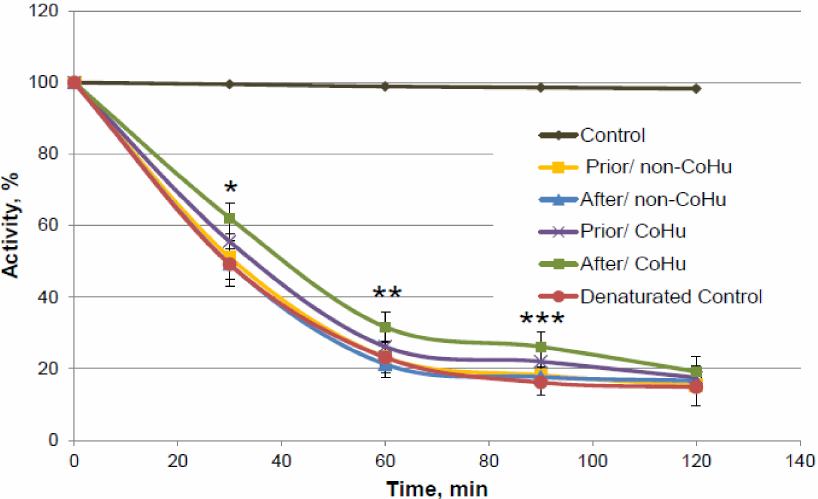
Figure 10. Catalase activity based on the residual quantity of H 2 O 2 (catalase substrate) in the catalase- assisted degradation reaction. Control—activity of intact enzyme. Prior/non-CoHu—activity in samples that were treated with non-CoHu before inactivation. After/CoHu—activity in samples that were treated with CoHu after inactivation. Prior/CoHu—activity in samples that were treated with CoHu before inactivation. In time points marked as *, ** and *** there is reliable difference between the groups ( p <